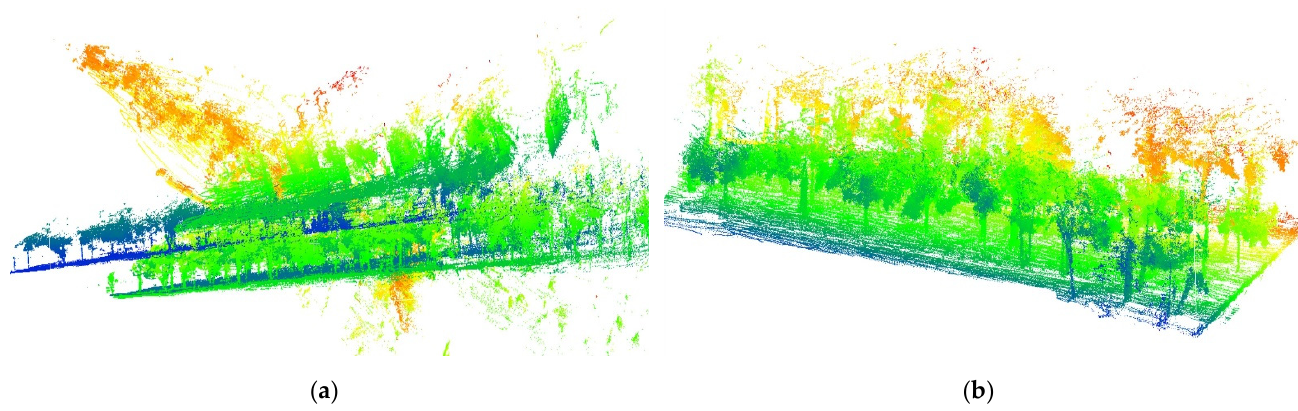
Figure 11. 3D reconstruction of LOAM-Livox algorithm.